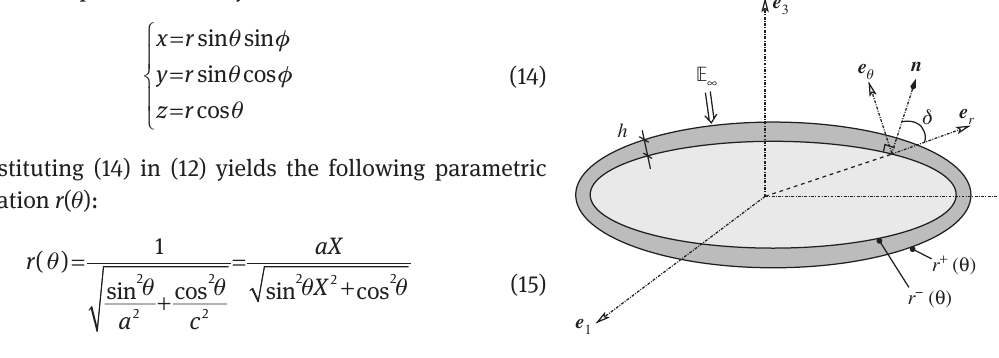
Figure 1 Geometrical